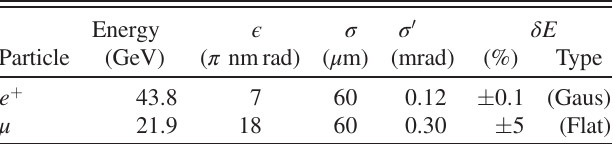
TABLE IV. Positron and muon beam parameters matching the transport